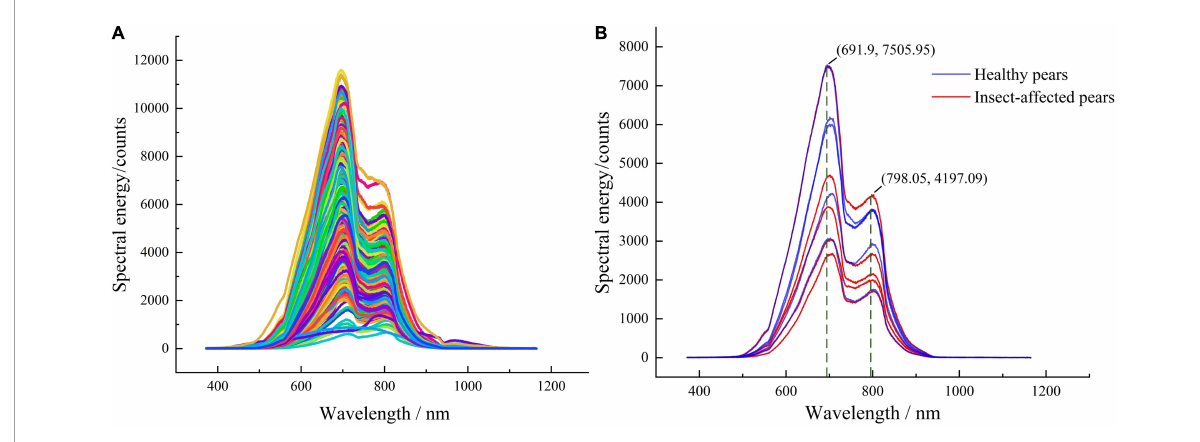
FIGURE6 Vis-NIR spectra of healthy pears and insect-affected pears (A) original Vis-NIR spectra, (B) spectra of some